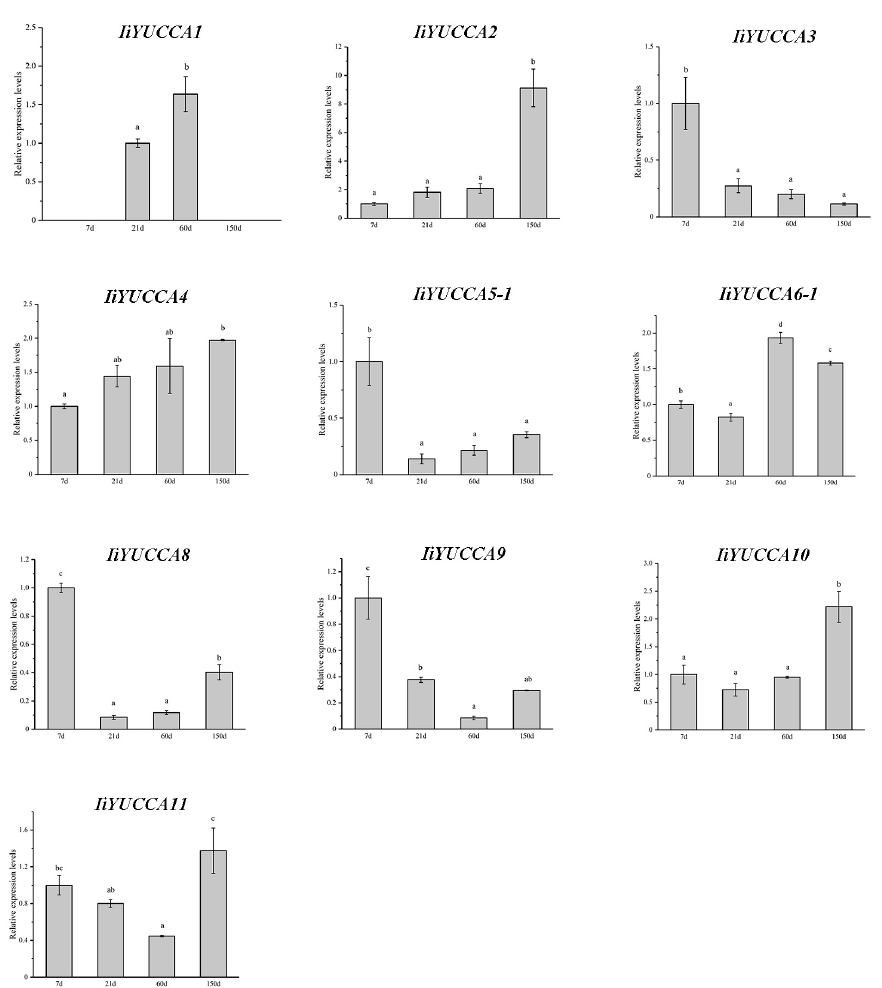
Figure 5. The expression patterns of YUCCA genes in different developmental periods from I. indigotica . Different lowercase letters indicate the significant differences for the relative expression at p < 0.05 level.